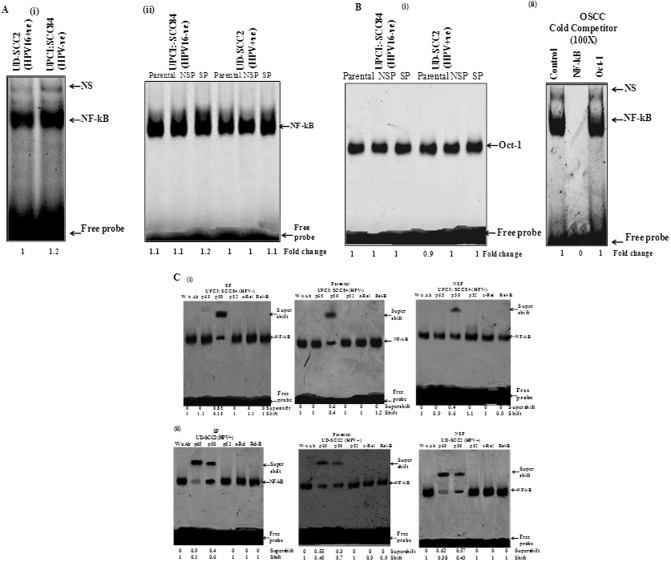
Effect of HPV16 infection on the constitutive activity of NF-κB and its composition in oral cancer stem cells.A. Constitutive activation and DNA binding activity of NF-κB in HPV+ve and HPV-ve oral cancer cells. EMSA showing DNA binding activity of NF-κB in nuclear extracts (10μg) of (i)HPV+ve and HPV-ve OSCC cells, (ii) in different sets of parental, NSP and SP cells of OSCC cell lines in both HPV+ve and HPV-ve cells using Cγ3- labeled oligonucleotide harboring an NF-κB consensus sequence. Fold change in the band intensities of NF-κB are indicated in each lane. The intensities of shifted bands quantified in densitometric analysis. B. EMSA showing binding specificity using nuclear extracts from OSCC cells, with a Cγ3-labelled oligonucleotide harboring an Oct-1 and NF-κB (right side) consensus sequence. (i) Oct-1 probe that showed consistent DNA binding in different sets of OSCC cells. (ii) Binding specificity was evidenced by pre-incubation with a 100 fold molar addition of the homologous unlabeled NF-κB oligonucleotide in comparison with competition experiments using a heterologous consensus sequence of the Oct-1 transcription factor. The positions of the specific retarded bands are indicated. C. Supershift assay showing altered composition of functional NF-κB complex in HPV+ve and HPV−ve OSCC cells. Nuclear extracts (10 μg) prepared from (i) SP, parental and NSP cells from oral cancer cell line UPCI:SCC84 (HPV-ve), (ii) SP, parental and NSP cells from UD-SCC2 (HPV+ve) oral cancer cell line as well as respective nuclear extracts were incubated with specific antibodies (2 μg each) against each of p65, p50, p52, c-Rel, RelB and assayed for NF-κB binding activity by band supershift asssay as described in Methods and band intensities quantified are indicated. The arrowhead indicates the super-shifted bands.